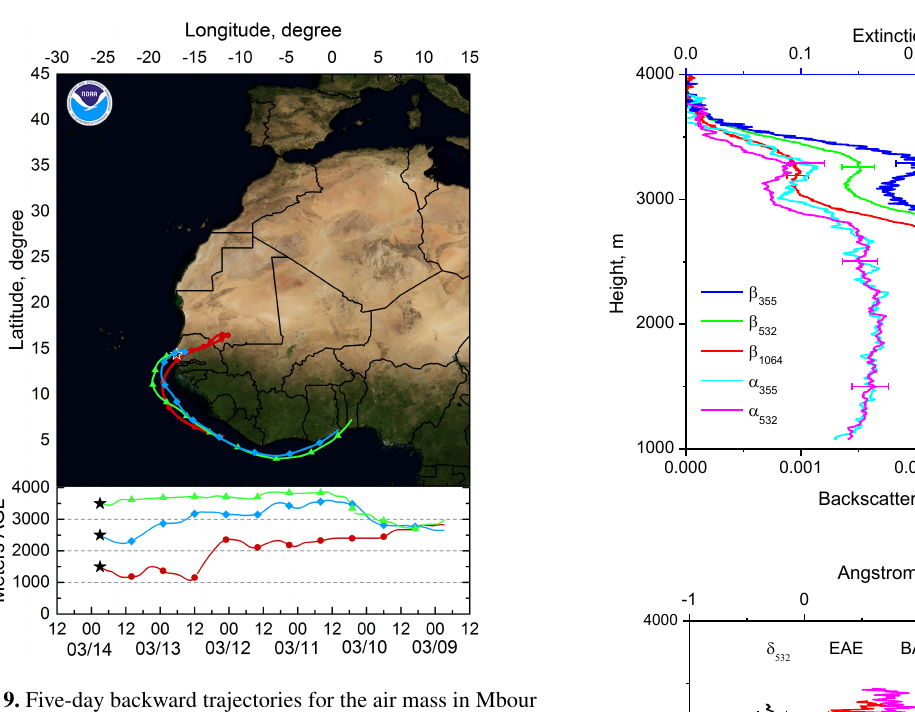
Figure 9. Five-day backward trajectories for the air mass in Mbour at altitudes of 1500, 2500, and 3500m on 13 March 2015 at 21:00UTC.